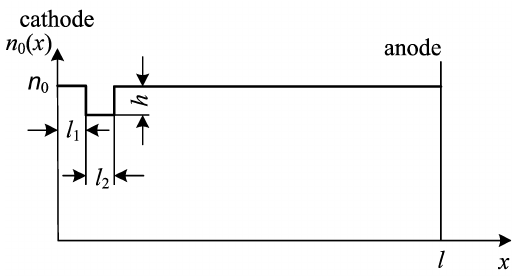
Figure 1 – Simplified active layer quasihomogeneous doping profile n 0 (x) of the